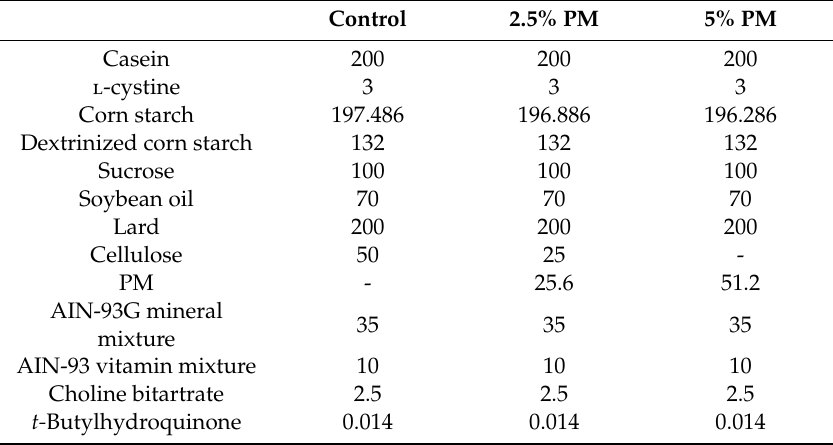
Table 1. Composition of the experimental diets (g / kg